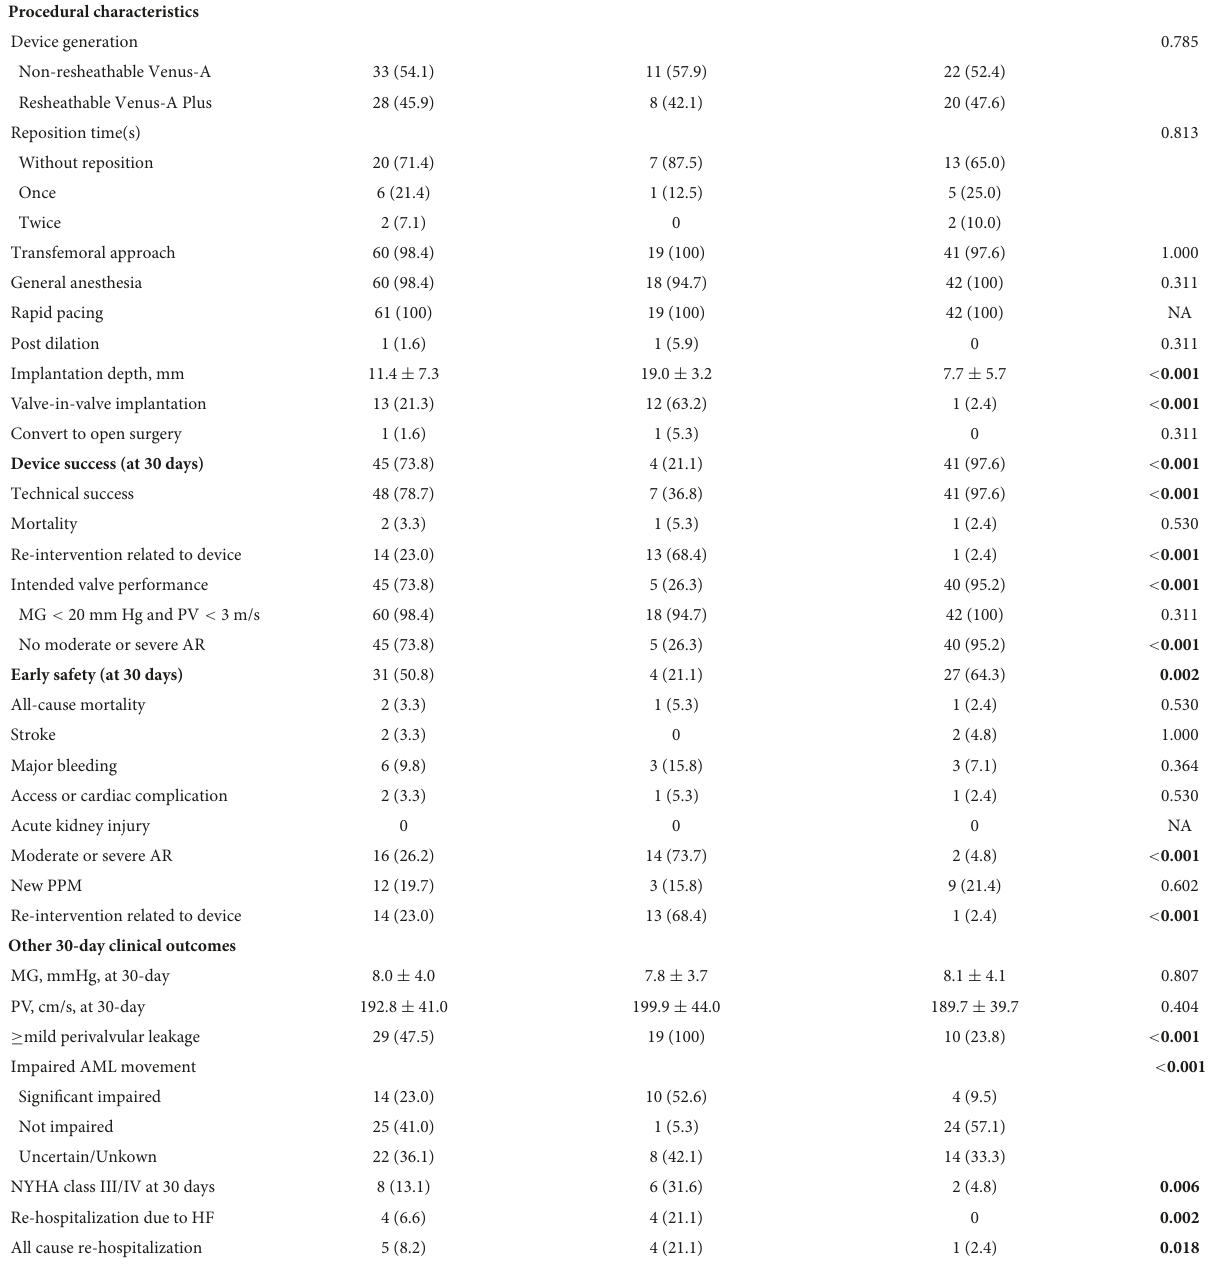
TABLE 3 Procedural characteristics and clinical outcomes.